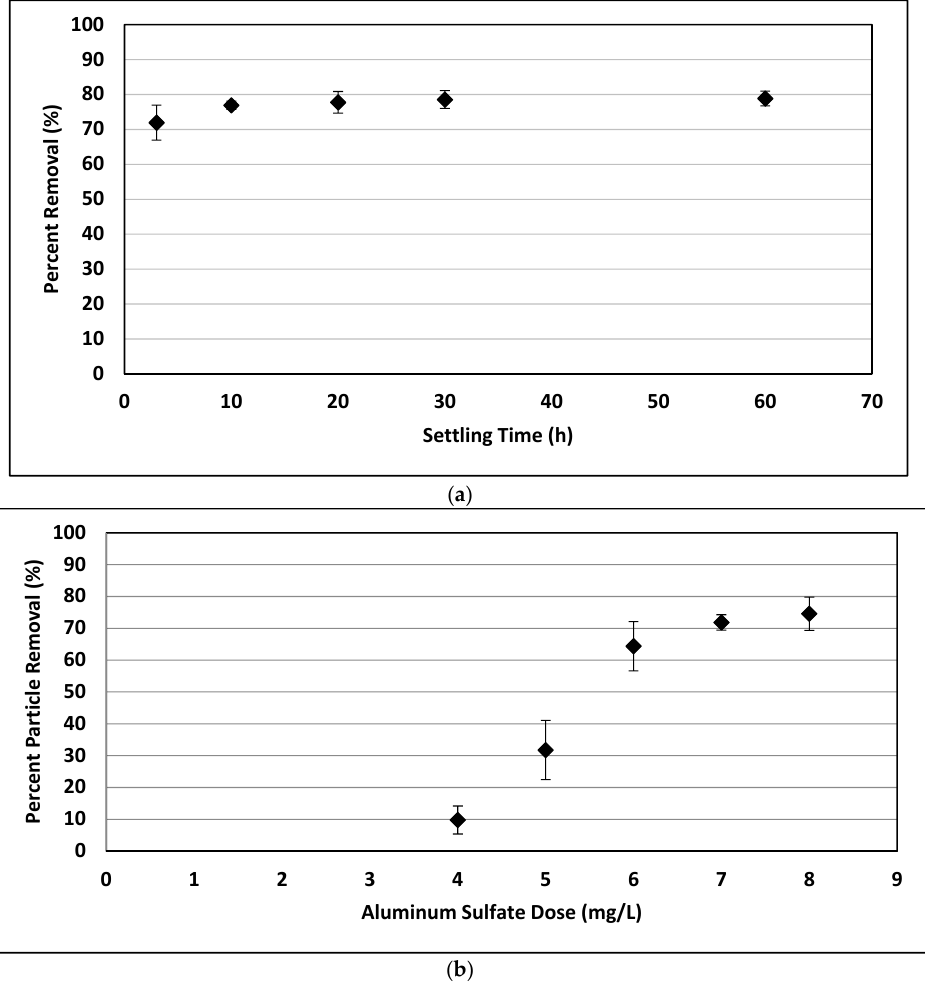
Figure 8. ( a ): Percent removal of nanoplastics by ballasted flocculation based on turbidity measurements (initial concentration = 5 mg/L; alum dose = 7 mg/L). ( b ): Percent removal of nanoplastics by ballasted flocculation with varying alum dose based on turbidity measurements (initial concentration = 5 mg/L; settling time = 3 min).